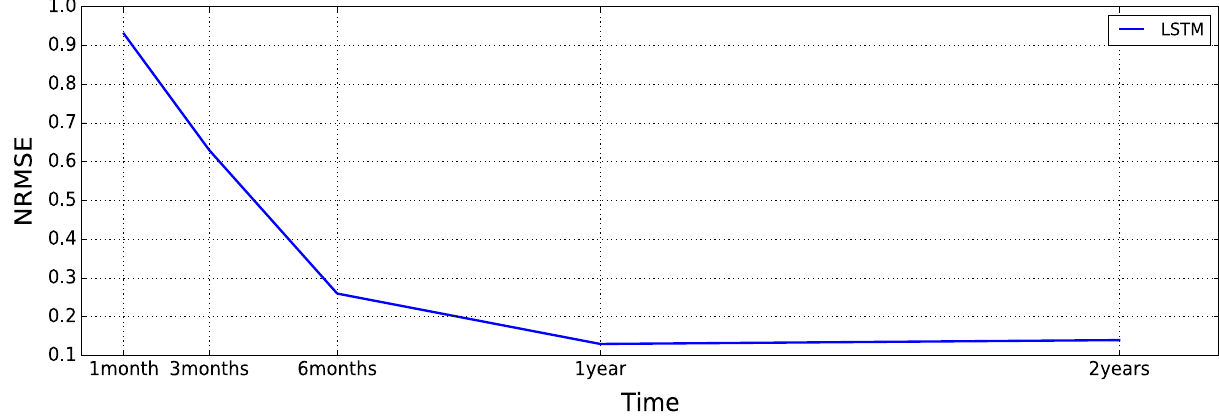
Figure 10. Sensitivity analysis on different training horizons (notice the loss error here is for one hour ahead forecast model of a 1-month test